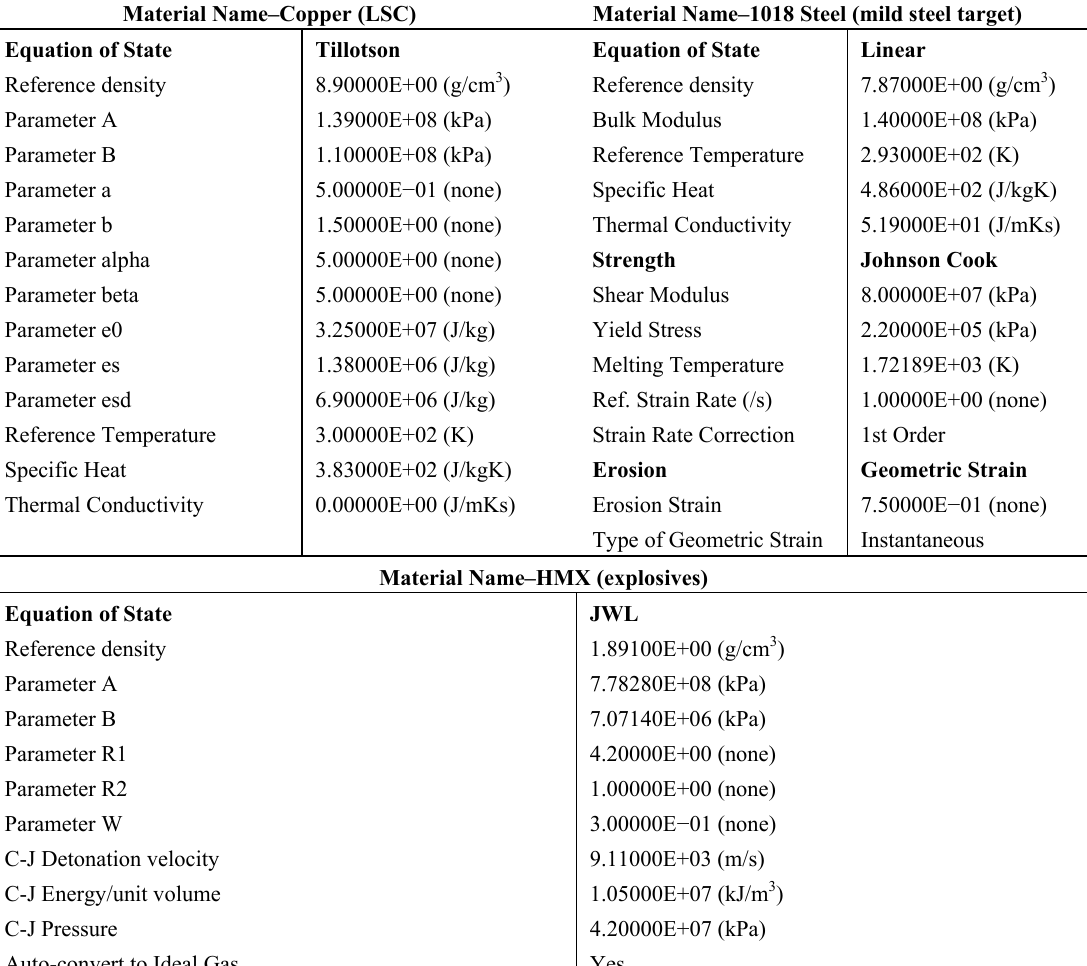
Table 1. Material properties of the simulation model template [6].